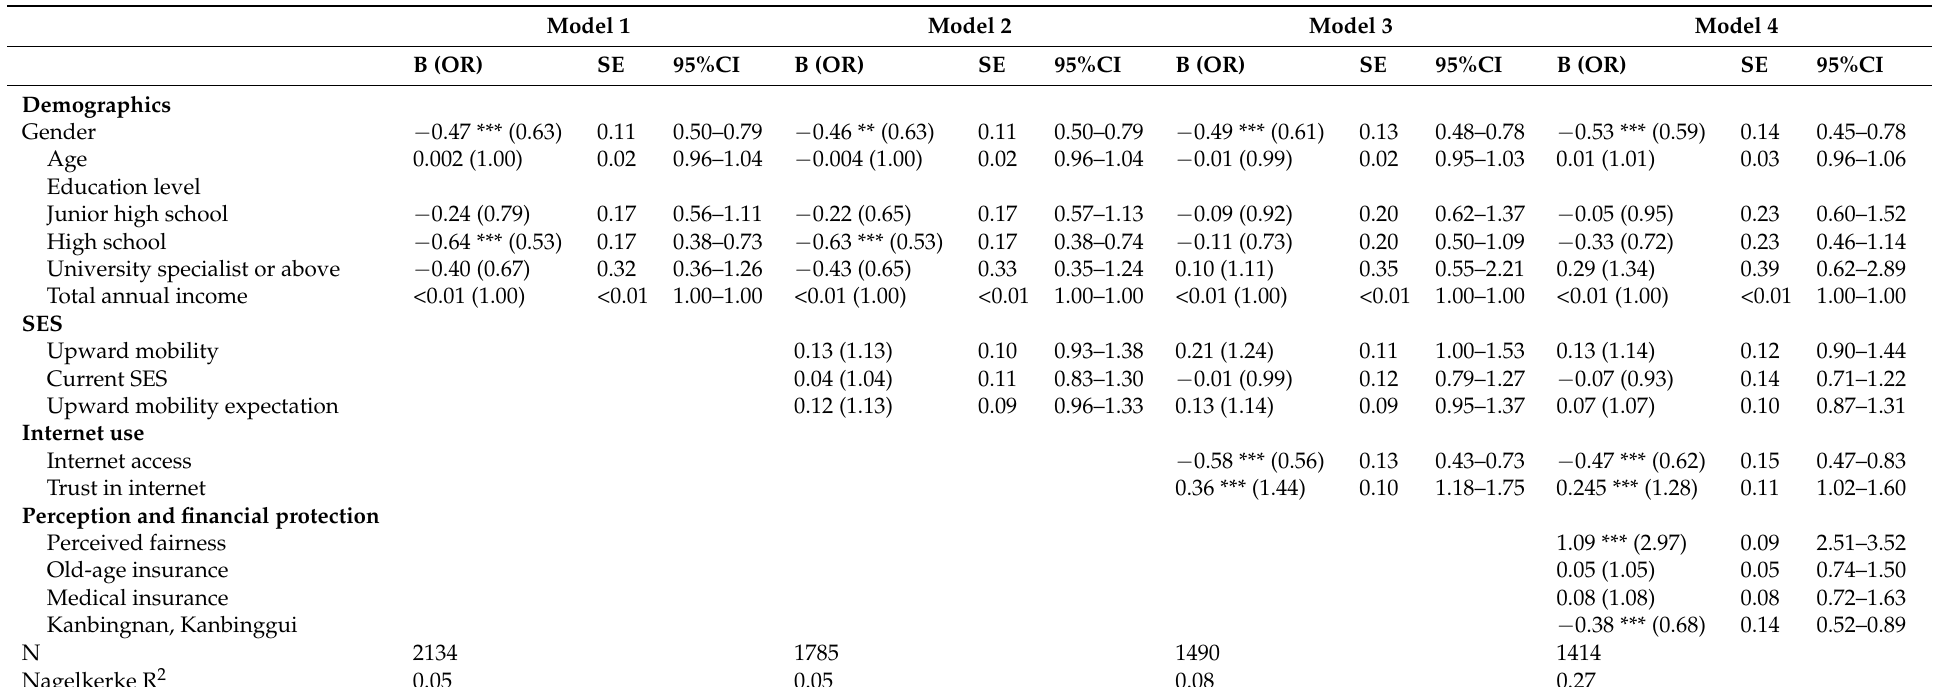
Table 3. Binary logistic regression models for the elderly’s trust in the healthcare